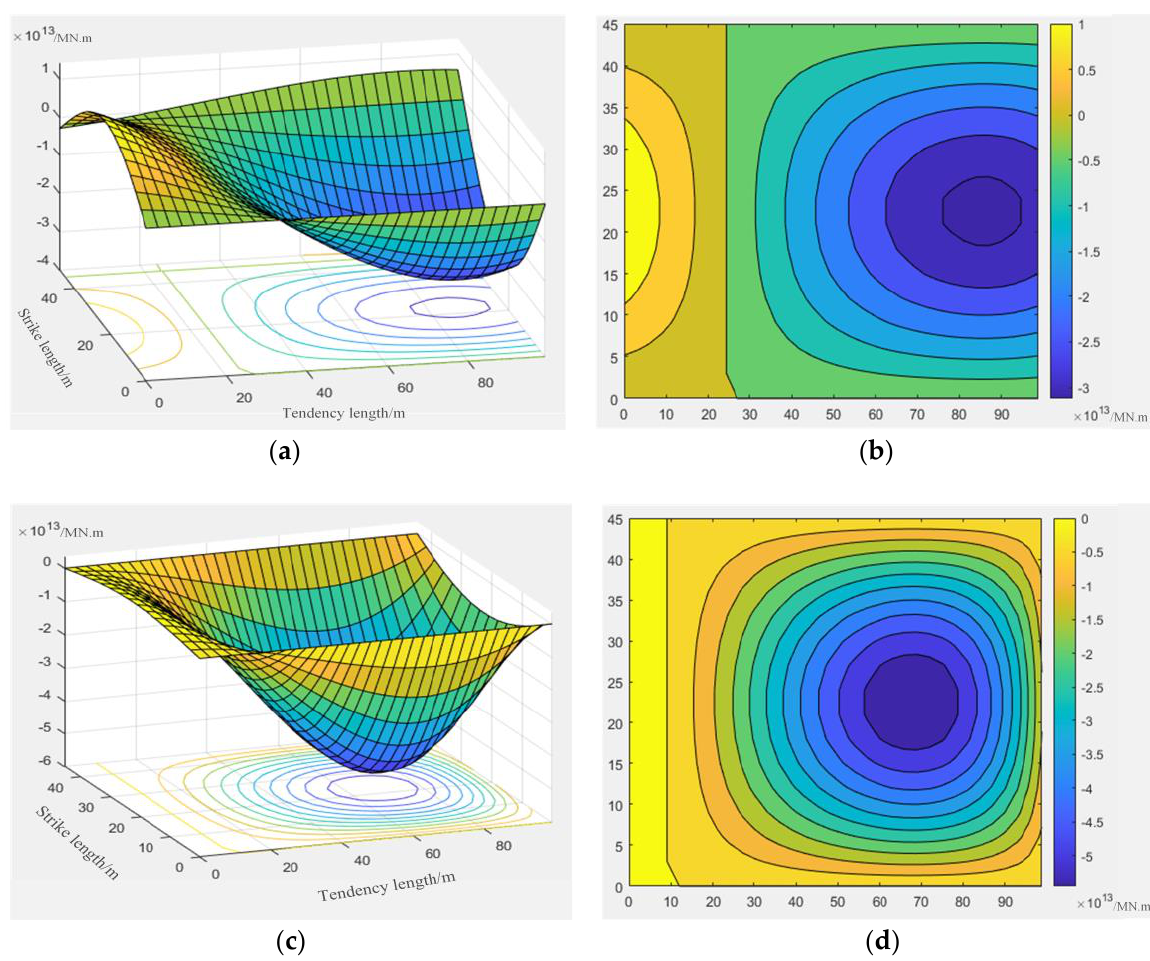
Figure 11. Three-dimensional surface contour map of internal force distribution of three-sided simply supported and one-sided fixed supported. ( a ) Diagram of bending moment M x ; ( b ) M x stress isoline diagram; ( c ) Diagram of bending moment My; ( d ) M y stress isoline diagram.